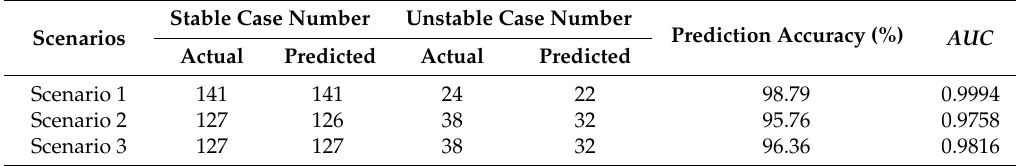
Table 5. Results of the prediction effect for unknown topology.